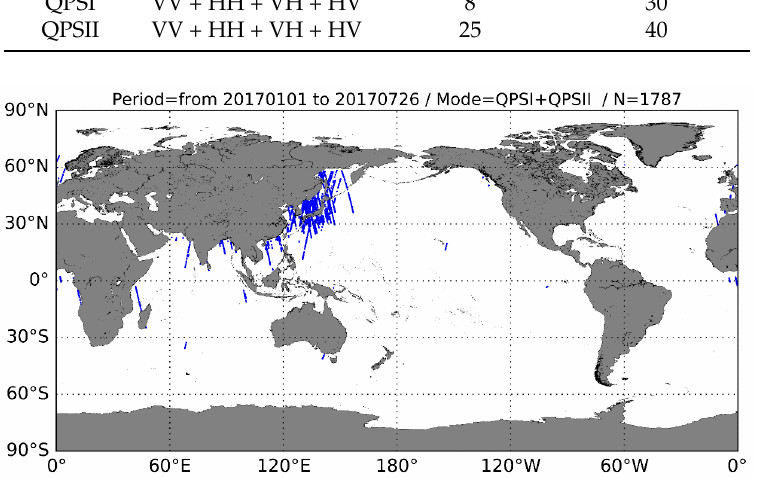
Figure 1. Location map of the 1787 GF-3 SAR data points acquired in the QPSI and QPSII modes. Each blue point represents a SAR data central location.